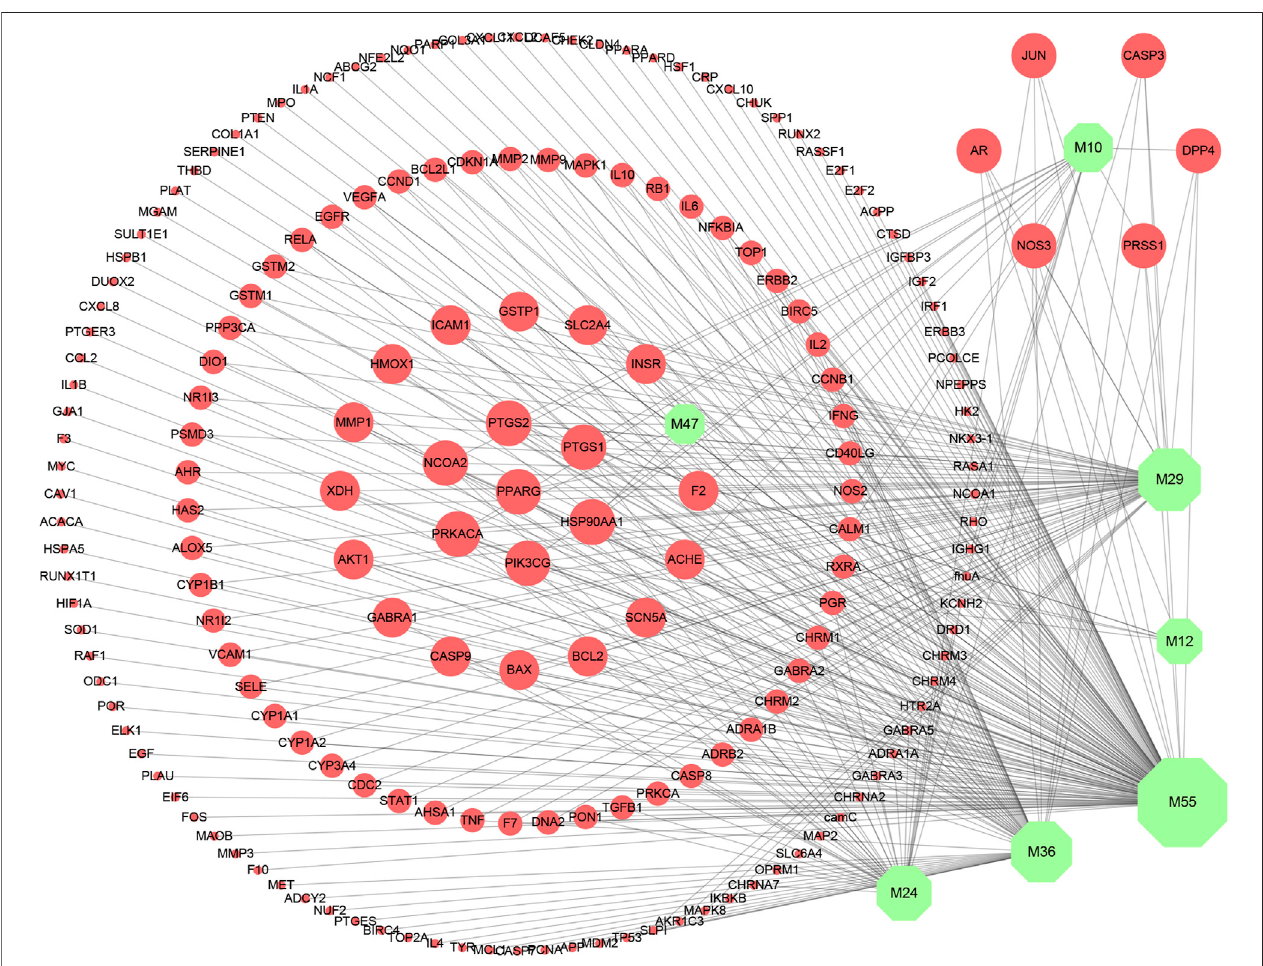
FIGURE 2 | Compound – target network. Green nodes represent compounds from Saussurea involucrata , and red nodes represent targets. The node size is proportional to its degree.